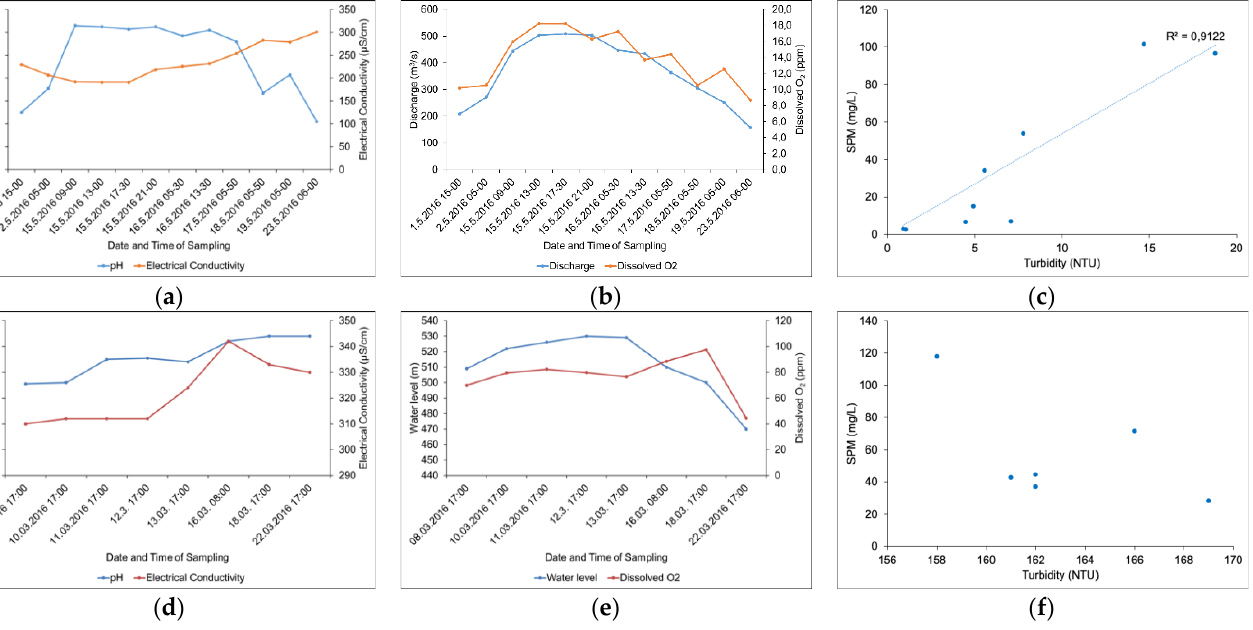
Figure 3. Time series of behaviour of ( a ) pH and electrical conductivity in Litija, ( b ) discharge and dissolved oxygen in Litija, ( c ) correlation of SPM concentration and turbidity in Litija, ( d ) pH and electrical conductivity in Belgrade, ( e ) water level and dissolved oxygen in Belgrade, and ( f ) correlation of SPM concentration and turbidity in